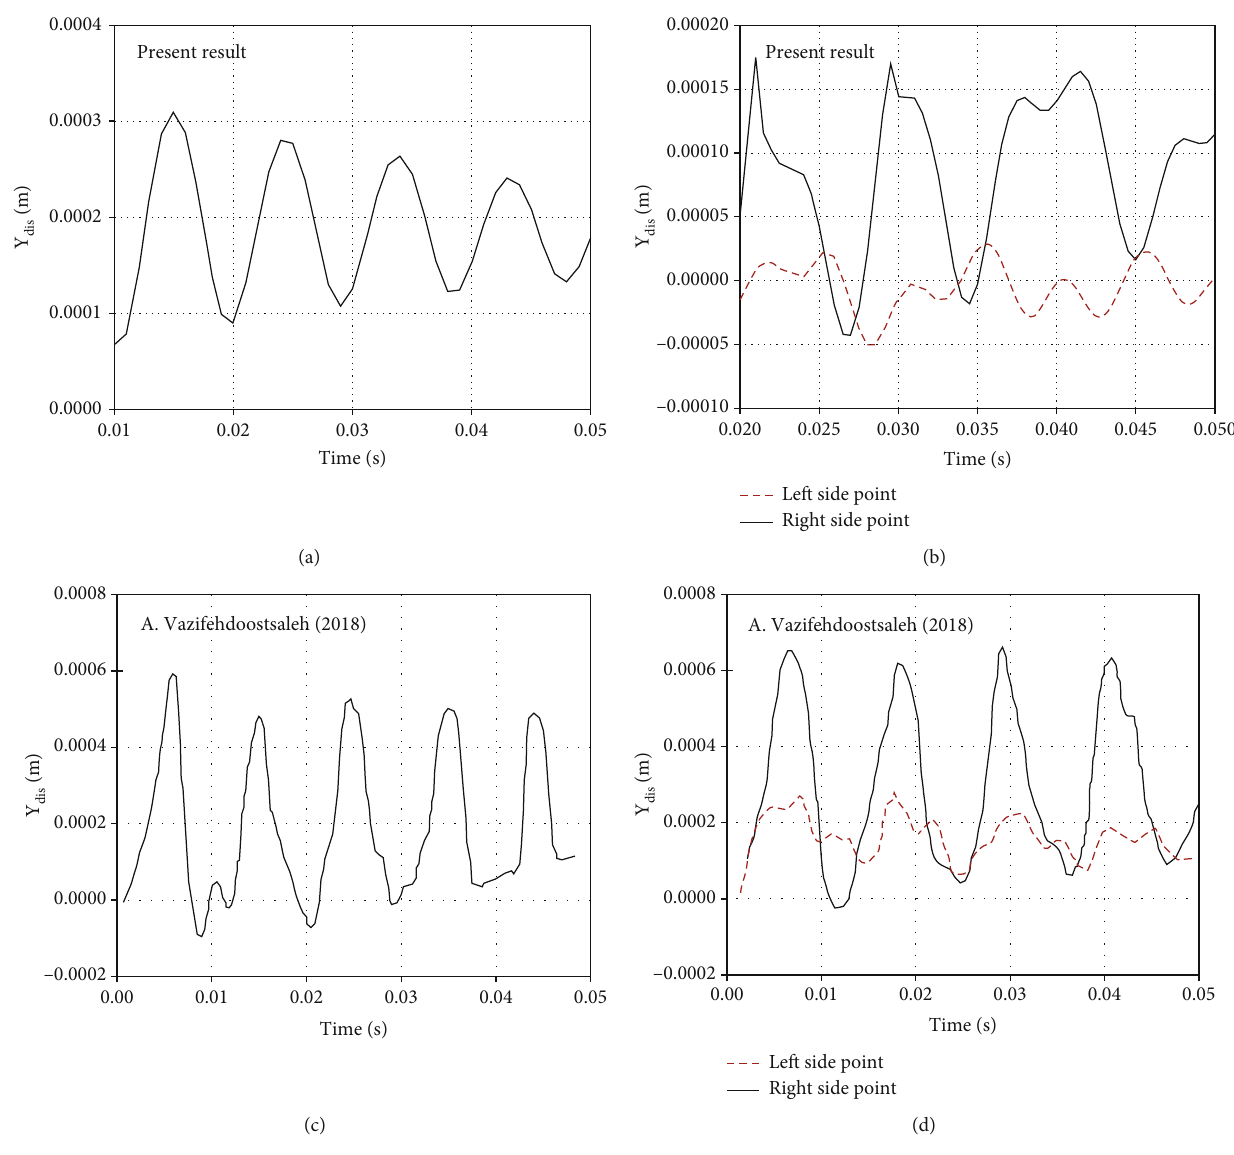
Figure 3: Variation of healthy vocal fold displacement versus time from this work (a) and A. Vazifehdoostsaleh ’ s result (c). Variation of right and left side displacement of sulcus vocalis (1 mm) versus time from this work (b) and A. Vazifehdoostsaleh ’ s result (d). Table 1: Comparison of fl ow parameters for healthy vocal folds and sulcus vocalis (1 mm). Typical range for healthy vocal